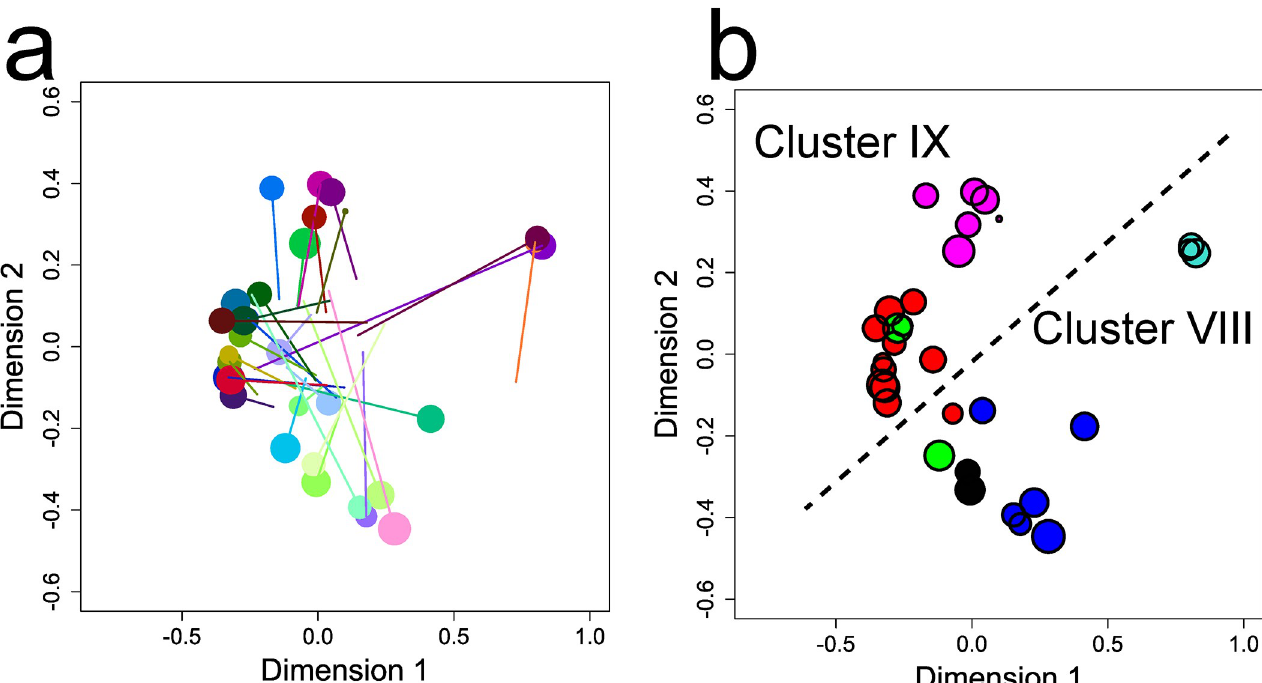
Fig 5. Genetic maps. a , Genetic map (points) with reference (lines) to the consensus antisera map (IgG at C2). Goodness-of-fit was not significant (R 2 = 0.07, P = 0.25). b , Genetic map coloured by PoLV groups. Point size is as for the consensus antisera map (see Fig 2).